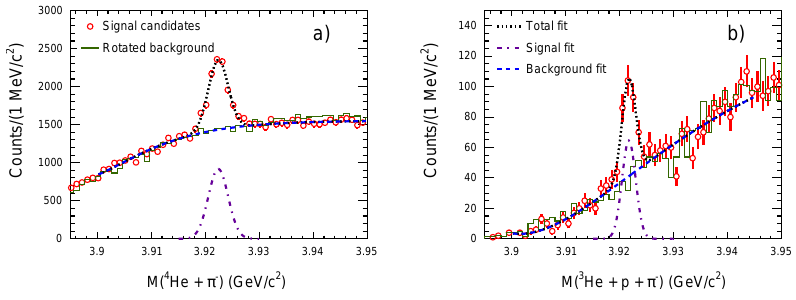
Figure 1. Invariant mass distributions for 4 Λ H and 4 Λ He reconstruction. The backgrounds are obtained by rotating 4 He or 3 He track by 180 degrees in the transverse plane. The black dashed curves represent fits with a Gaussian function plus double exponential functions. This figure is from [15].